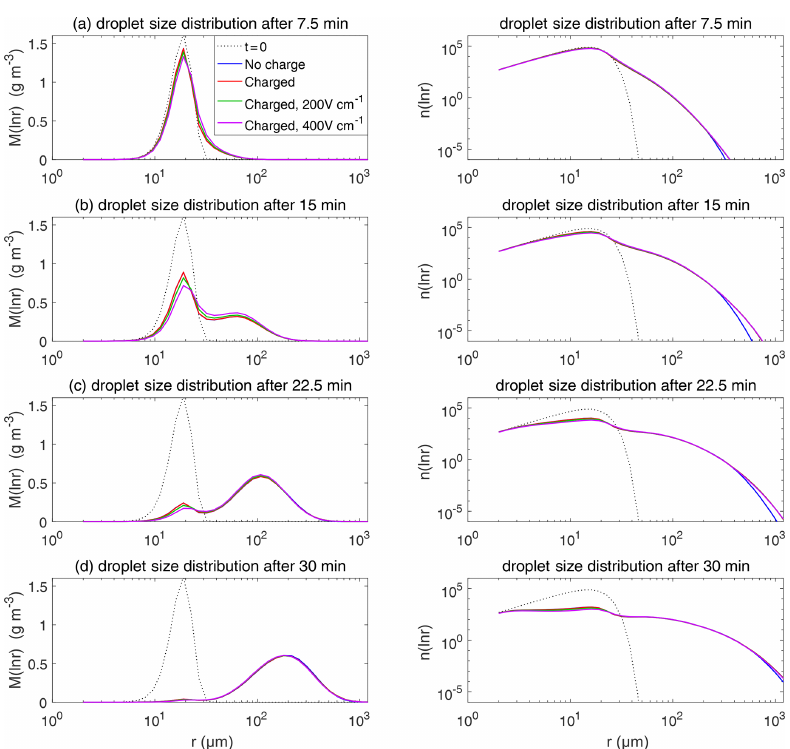
Figure 9. The evolution of droplet size distribution with initial ¯ r = 15µm. These panels show the different stages of the evolution from top to bottom. The left column shows the size distribution of the droplet mass concentration, and the right column shows the size distribution of the droplet number concentration on logarithmic scales. In each panel, comparisons are made for four different electric conditions. Blue lines denote the uncharged cloud. Red lines denote the charged cloud without an electric field. Green and purple lines denote the charged cloud with a field of 200 and 400Vcm − 1 , respectively. Dotted lines show the initial size distribution.